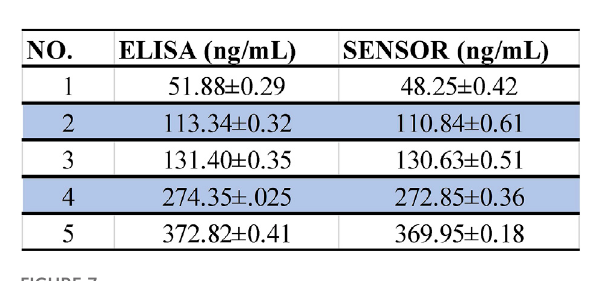
FIGURE 7 Statistics of ELISA and sensor detection results of the same